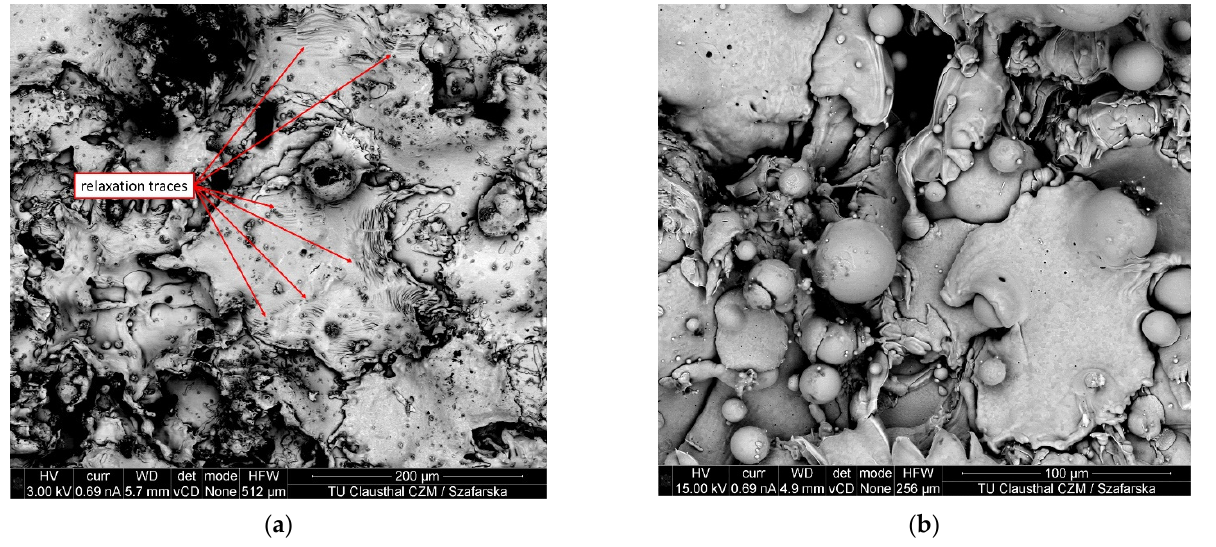
Figure 14. SEM images of representative copper splats on the coating surface: ( a ) formed in air, featuring relaxation traces, and ( b ) formed in silane-doped nitrogen.